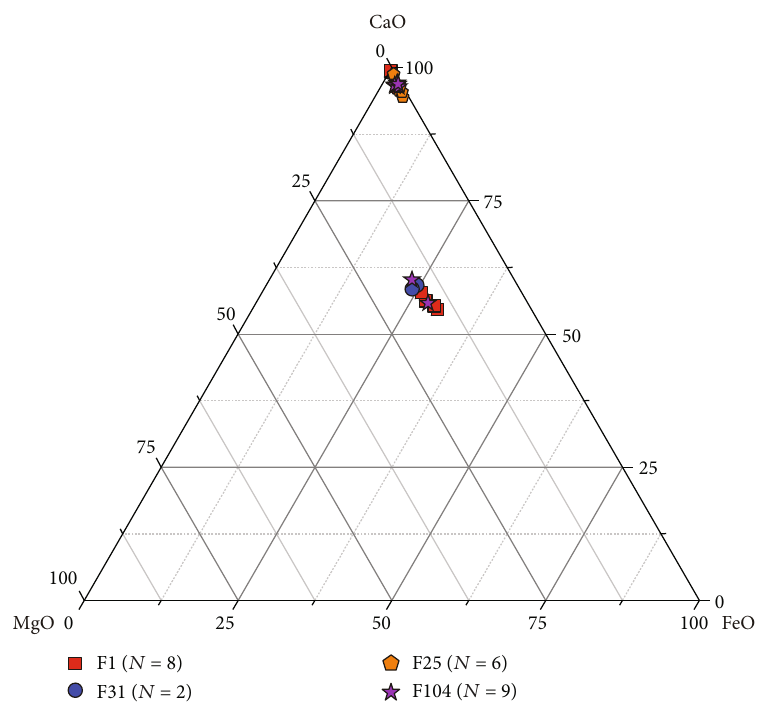
Figure 15: Ternary diagrams showing normalized compositions of carbonate cement from EPMA analysis in